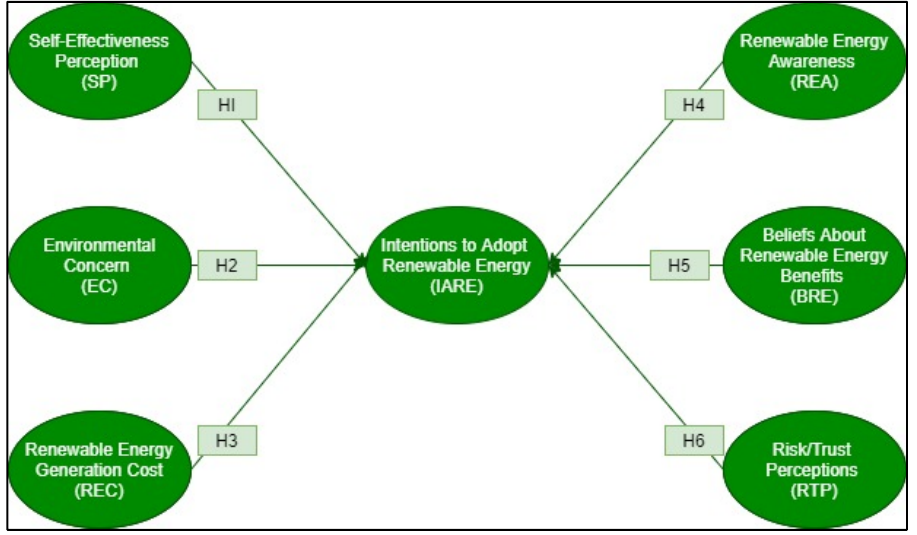
Figure 1. Adopted Research Model for the Study.